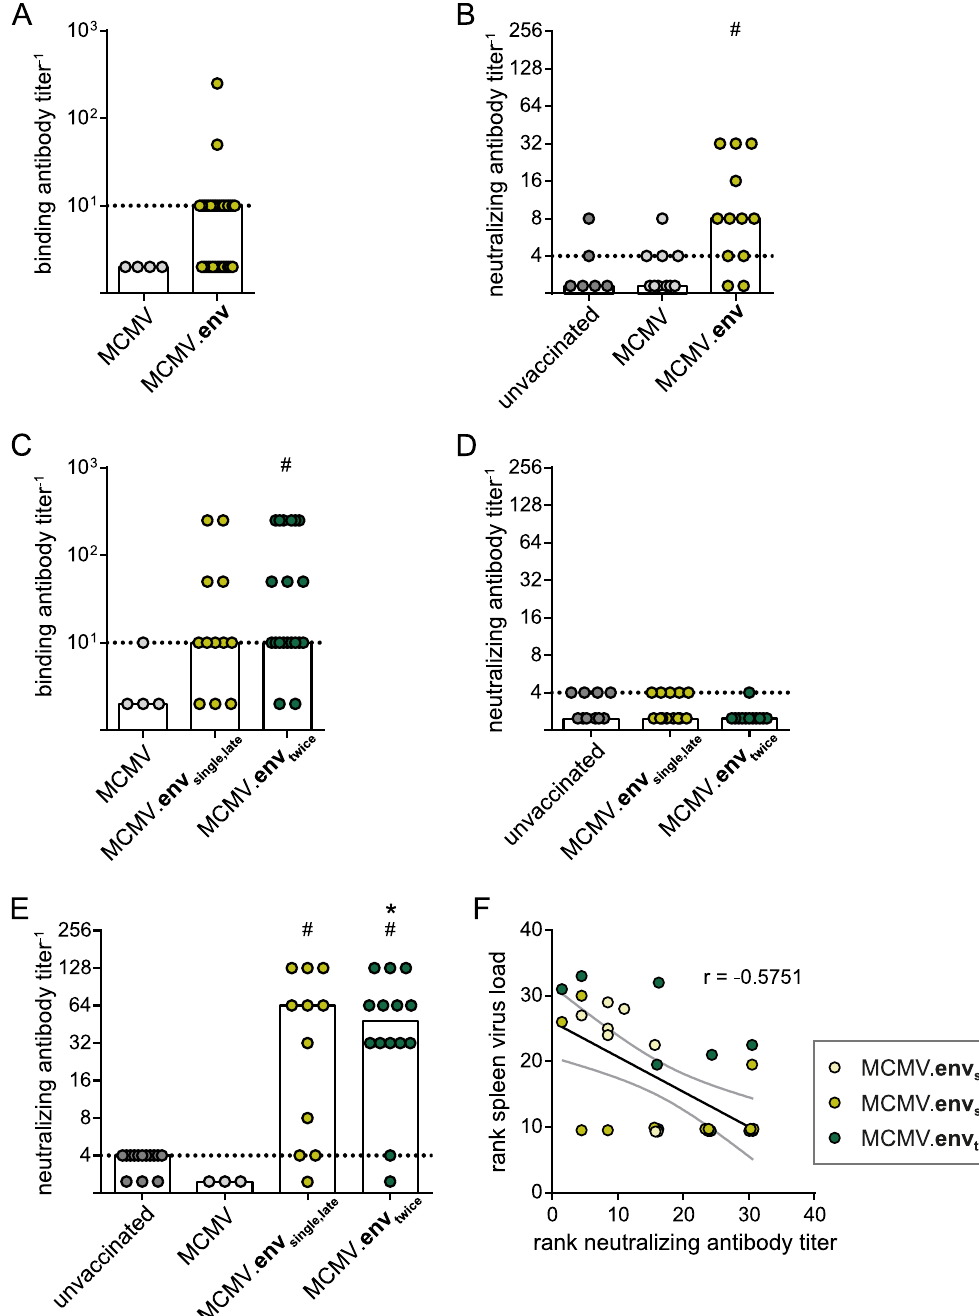
Fig 5. Antibody response to MCMV.env immunization. CB6F1 mice were immunized with MCMV.env, or a non-transgene- encoding control MCMV, either once, or twice in a three-week time interval. Binding antibody responses were analysed two weeks after the first immunization (A) and five weeks after the first immunization (C). Neutralizing antibody responses were analysed ten days after FV challenge infection in the early challenge setting (B), five weeks after the first immunization in the late-challenge setting (D) or ten days after infection in the late-challenge setting (E). (F) Spearman ranked correlation analysis showing ranked spleen viral loads shown in Figs 3D and 4D and ranked neutralizing antibody titers shown in (B) and (E). Dots representing identical rank values were off-set for visualization, but analysis of correlation was performed with original, identical values. Each dot indicates an individual mouse, columns indicate median values, dotted lines indicate the limits of detection, grey lines indicate the 95% confidence interval. Data were obtained in two (A, C, D: MCMV), three (B; A, C, D: MCMV.env single,late ) or five independent experiments (A, C, D: MCMV.env twice ; unvaccinated). Statistically significant differences compared to unvaccinated mice are indicated by � , significant